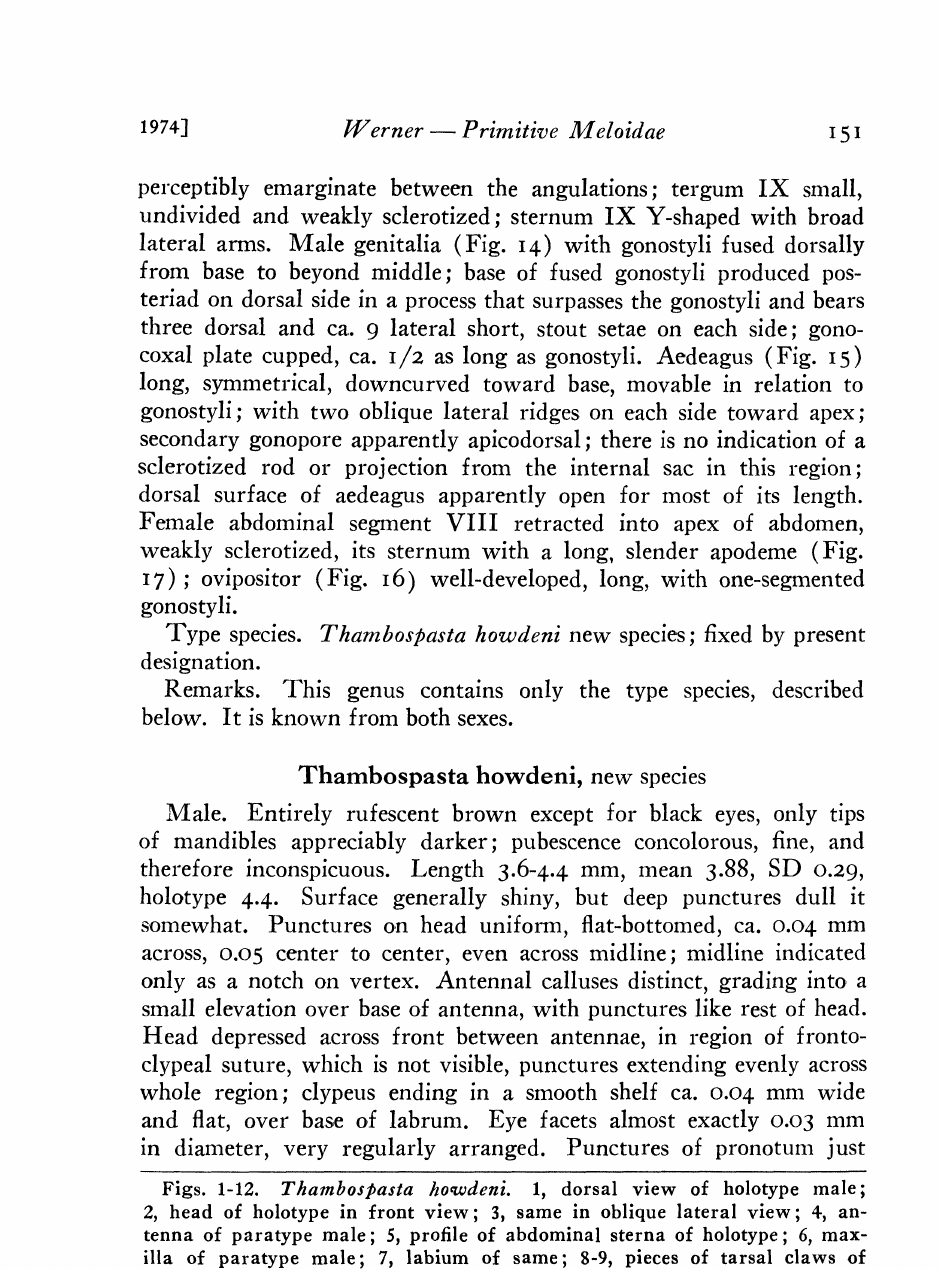
tenna of paratype male; 5, profile of abdominal sterna of holotype; 6, max- illa of paratype male; 7, labium of same; 8-9, pieces of tarsal claws of same; 10, tip of front tibia of same; 11, front tarsus of same; 12, detail of front tarsal claws, ventral